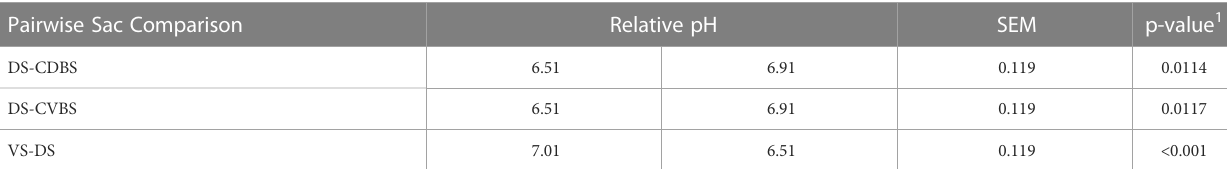
TABLE 2 Relative pH differences among the fi ve rumen